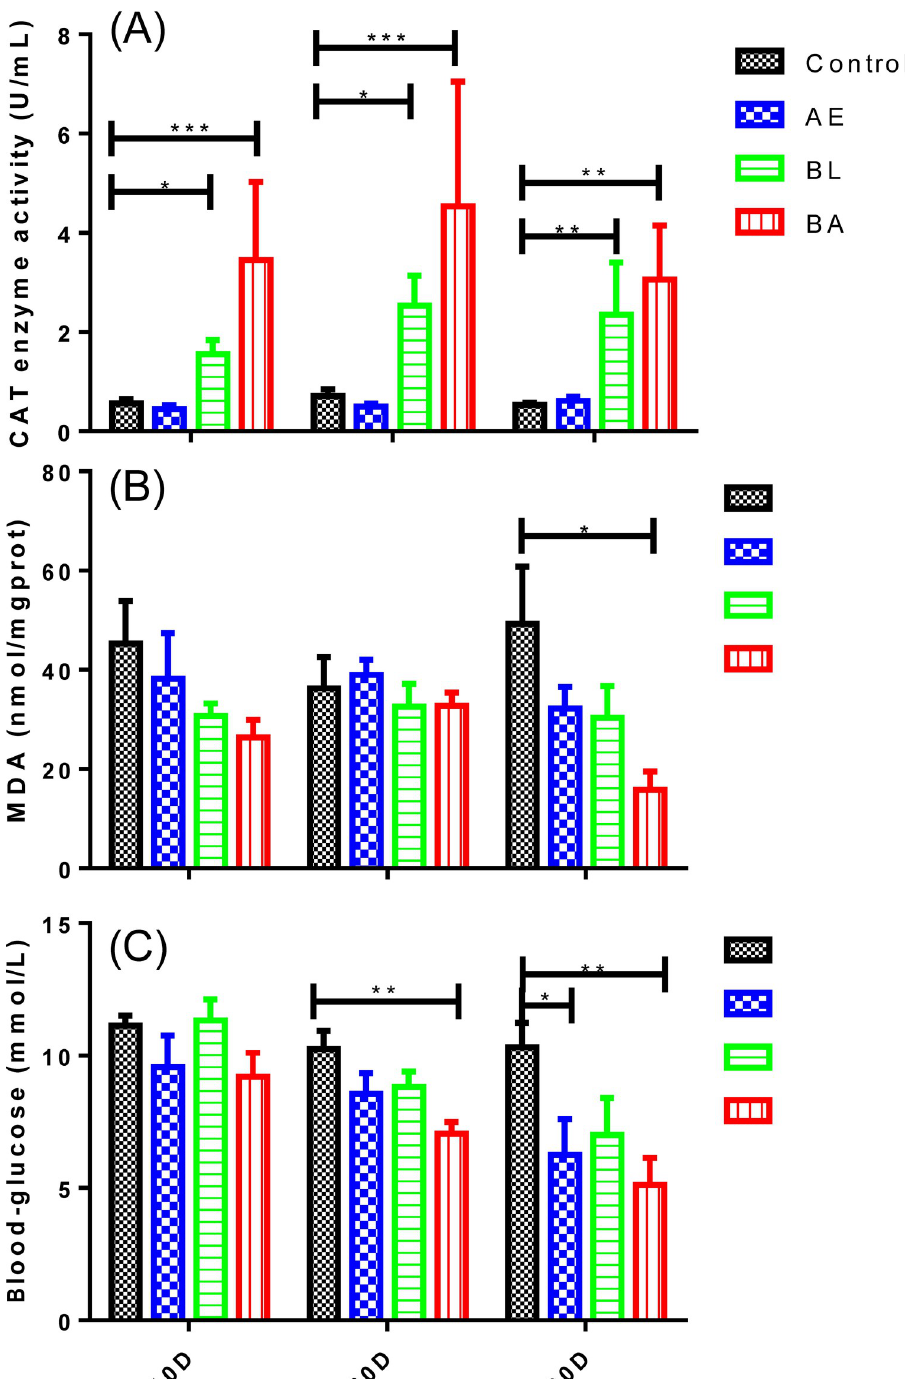
Fig 3. CAT activity (A), MDA content (B) and blood glucose content (C) of InR [E19] /TM2 D . melanogaster on days 10 (10D), 20 (20D), and 30 (30D) in the four groups. AE: Astragalus membranaceus extract, BL: Bacillus licheniformis and BA: Bacillus licheniformis and Astragalus membranaceus extract. � p < 0.05, �� p < 0.01, ��� p < 0.001 indicates significance between the control and experimental groups.